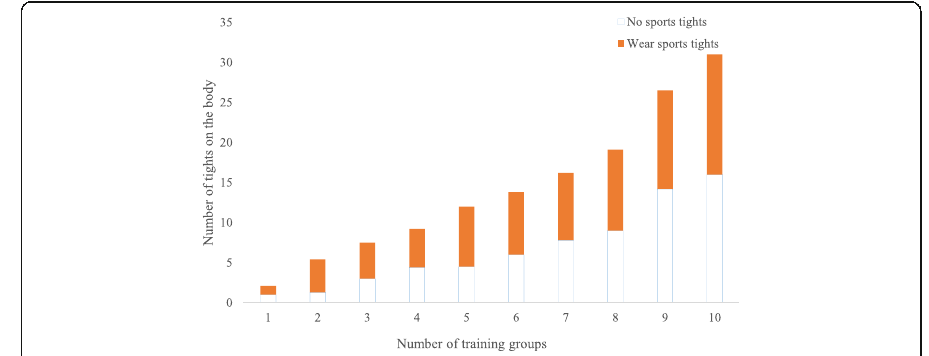
Fig. 5 Number of stresses in sports tights during